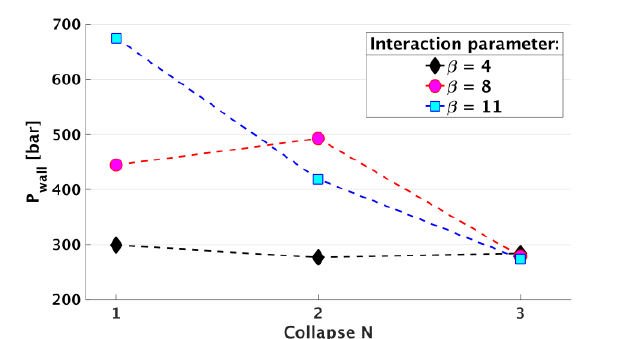
Fig. 5: Maximum pressure peaks recorded by the numerical wall pressure transducer subsequent to consecutive